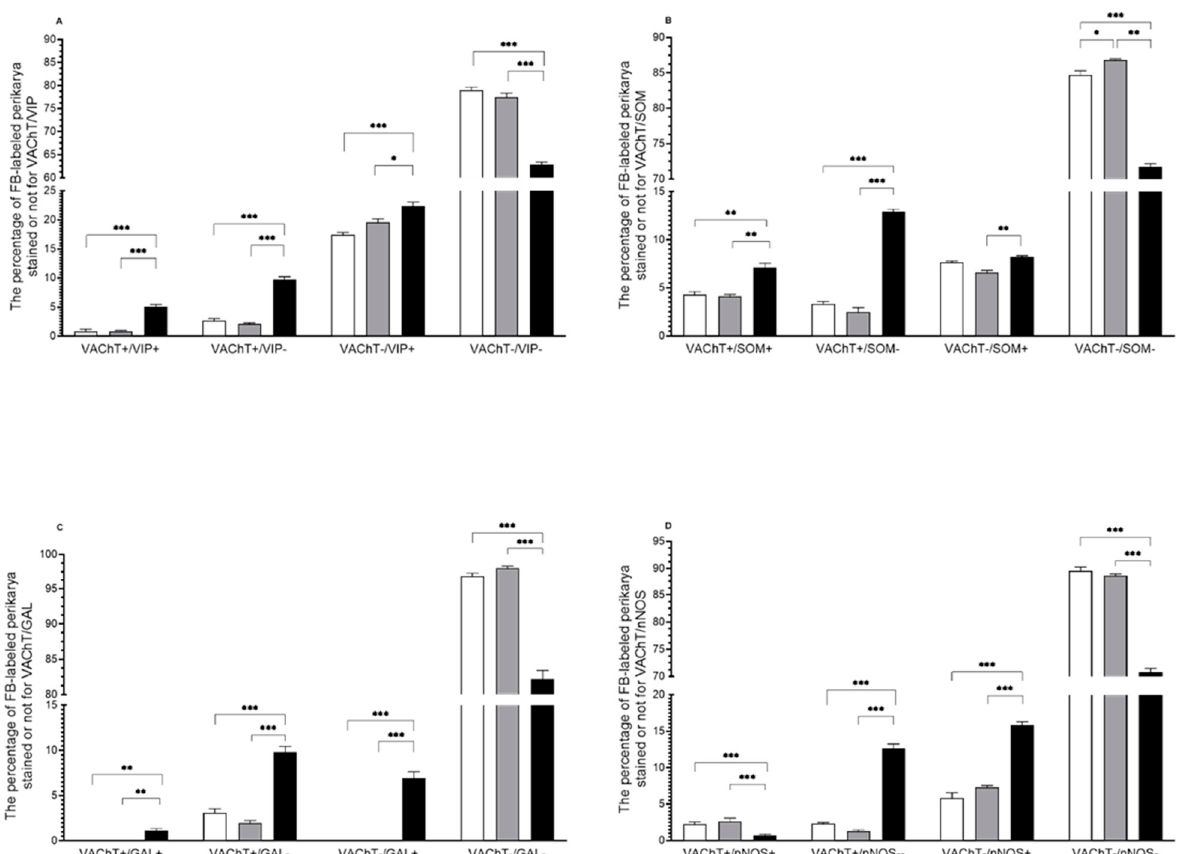
Figure 1. The populations (expressed as percentages, mean ± SEM) of uterine perikarya expressing vesicular acetylcholine transporter (VAChT) and/or vasoactive intestinal polypeptide (VIP) ( A ), VAChT and/or somatostatin (SOM) ( B ), VAChT and/or galanin (GAL) ( C ), and VAChT and/or neuronal isoform of nitric oxide synthase (nNOS) ( D ), as well as those without these substances in the PCG of gilts from the control (white bars), saline (grey bars), and E . coli (black bars) groups. Data are expressed as percentages of the total population of uterine perikarya stained for two substances in each group, accepted as 100%. * p < 0.05, ** p < 0.01, and *** p < 0.001 show differences between all groups for the same population of uterine perikarya.